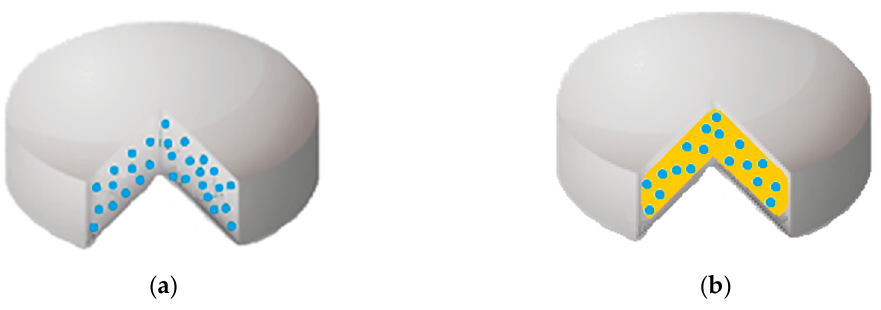
Figure 4. Possible PVP-based tablets: ( a ) monolithic matrix systems; and ( b ) osmotic systems or core–coating structure.